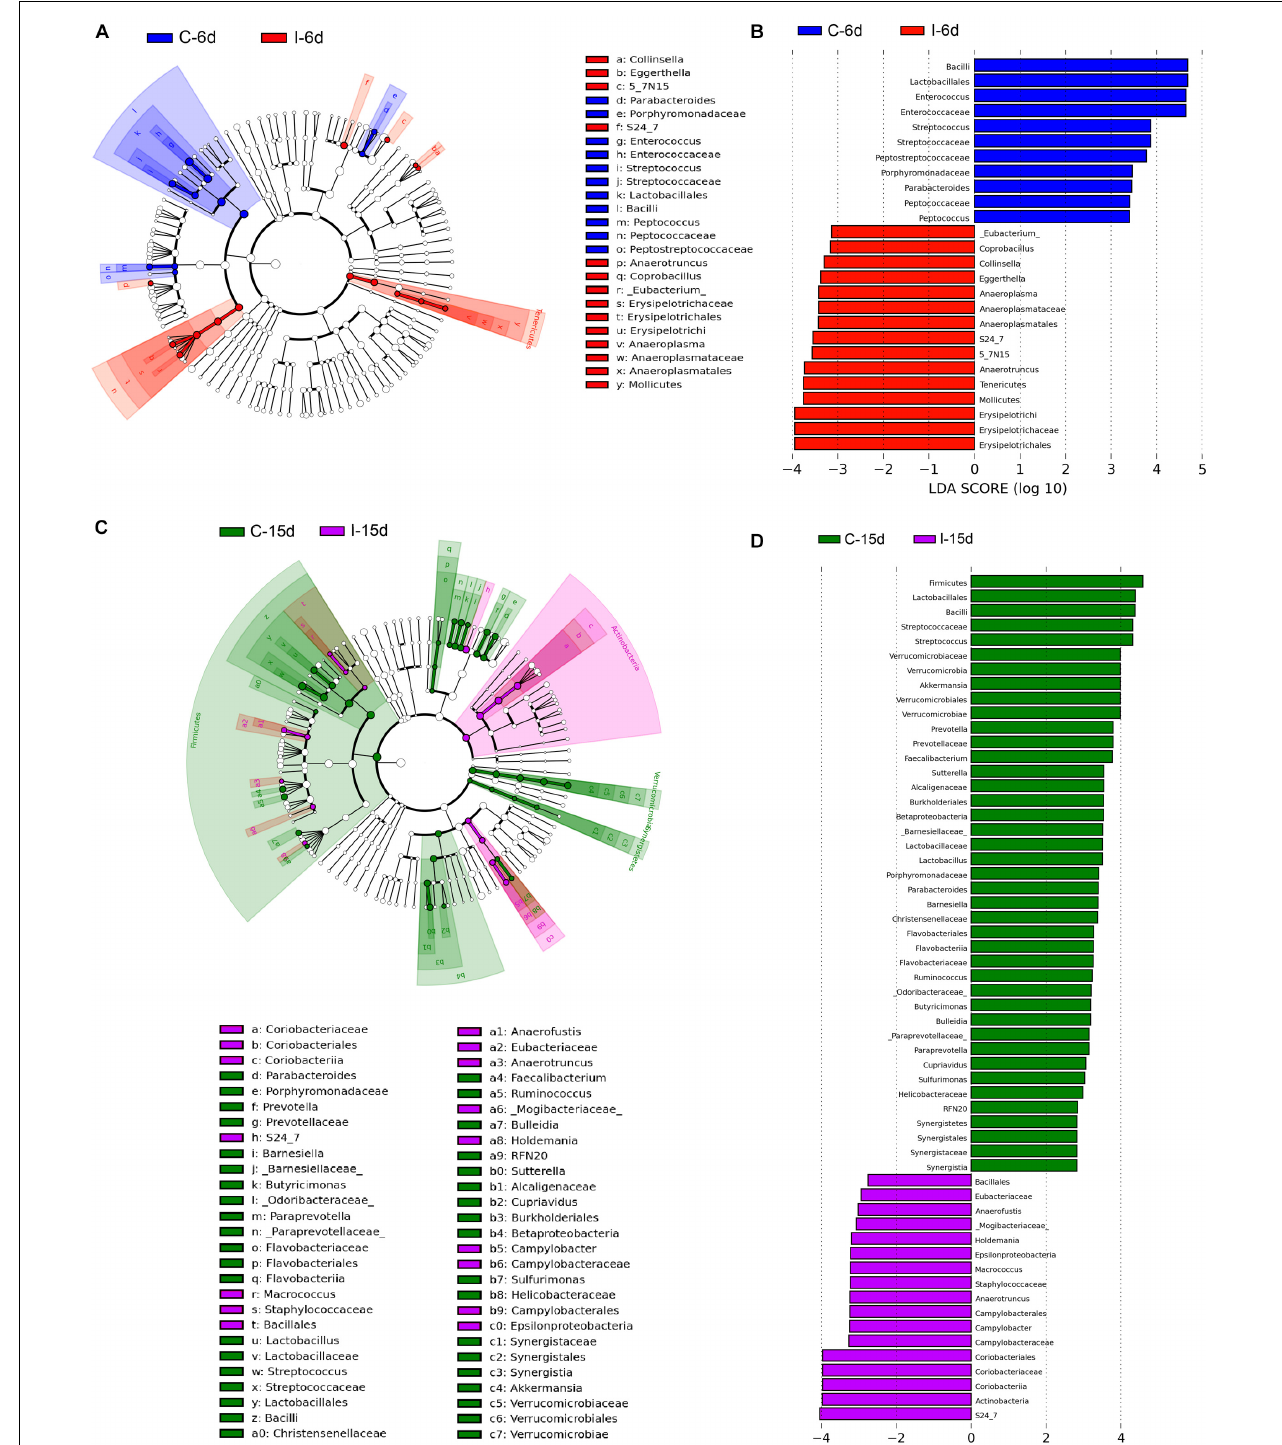
FIGURE 4 | The difference of abundances in taxa between the D-GPV-infected groups and the control groups. (A) Taxonomic cladogram obtained from LEfSe sequence analysis at 6 dpi. Biomarker taxa are highlighted by colored circles and shaded areas. Each circle’s diameter reflects the abundance of that taxa in the community. (B) The taxa whose abundance differed between the D-GPV-infected samples (I-6d) and the healthy control samples (C-6d) at 6 dpi. The cutoff value of ≥ 2.0 used for the linear discriminant analysis (LDA) is shown. (C) Taxonomic cladogram obtained from LEfSe sequence analysis at 15 dpi. (D) The taxa whose abundance differed between the D-GPV-infected samples (I-15d) and the healthy control samples (C-15d) at 15 dpi.